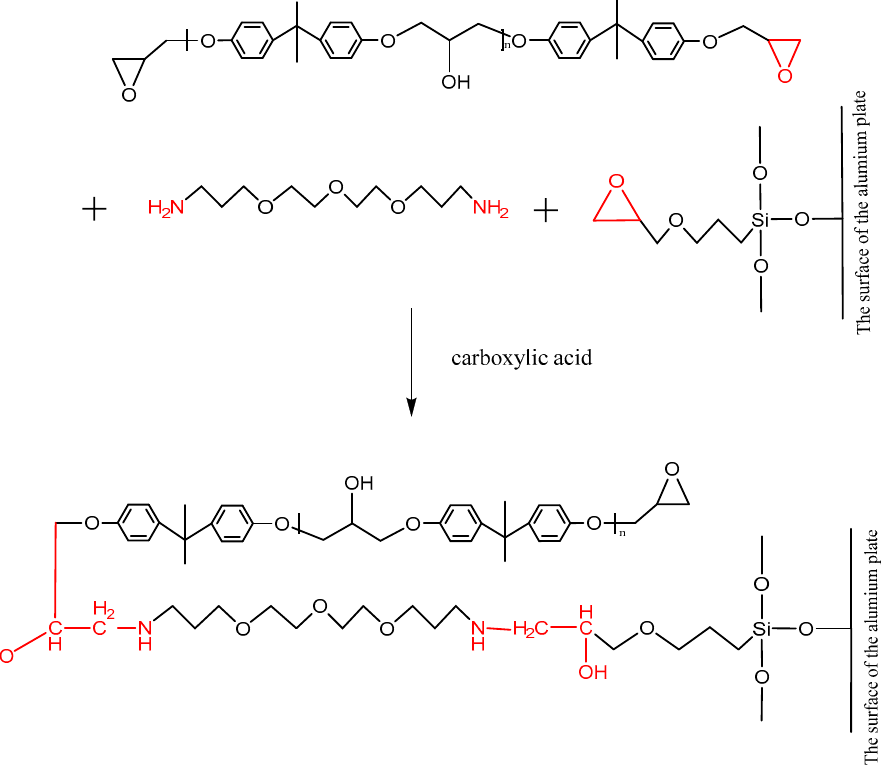
Polymers 2020 , 12 , x FOR PEER REVIEW 14 of 18